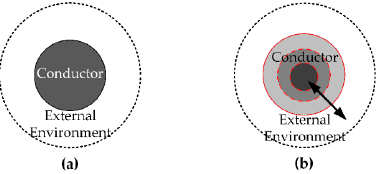
Figure 1. Simplified heat transfer analysis of the overhead transmission line cross-section. ( a ) Conductor is considered isothermal; ( b ) Only the radial heat transfer path is considered.